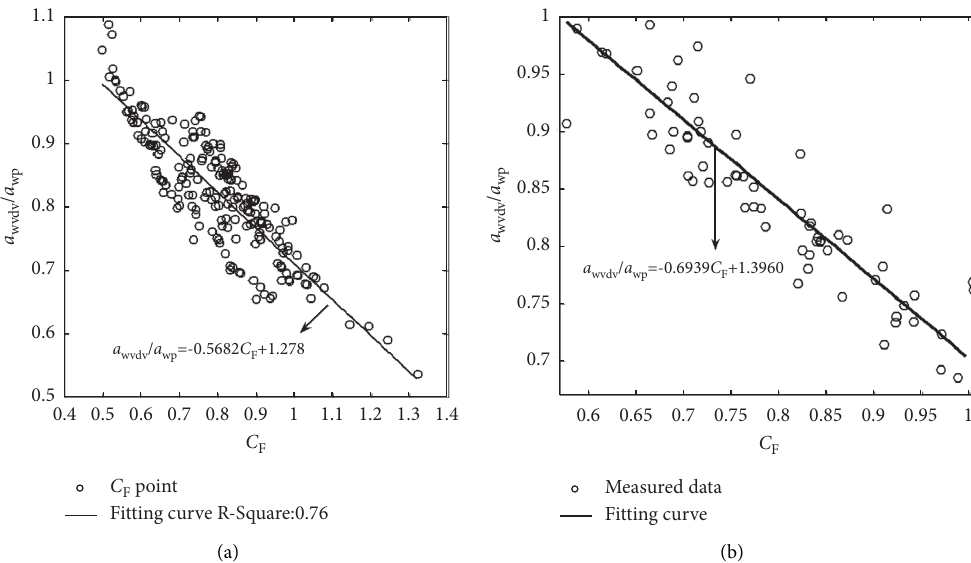
Figure 7: a wvdv / a wp plotted against C F . (a) Measured data from shaking table tests; (b) measured data from human